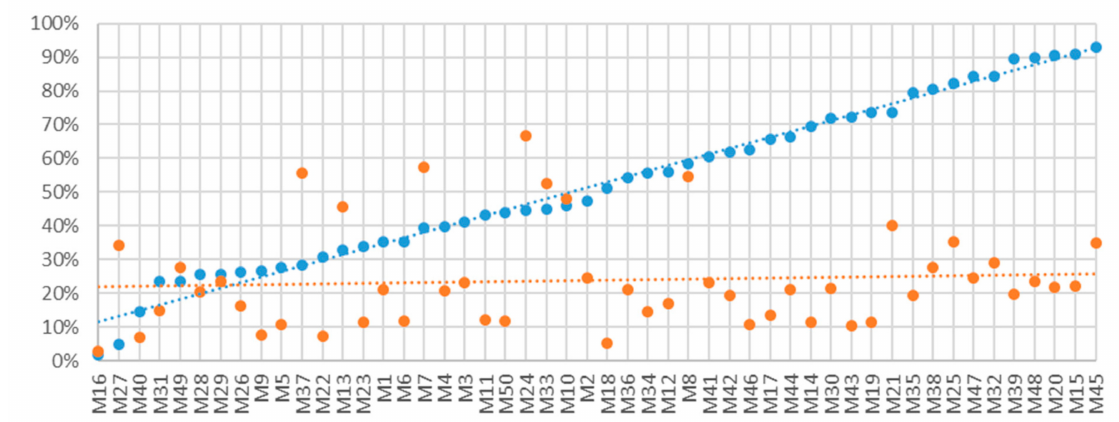
Figure 8. Graphic map load of the Ref-Set maps from user testing (L UP , marked blue) and measured by the AD metric (L AD , marked orange) sorted in ascending order by L UP , dotted lines indicate trend.